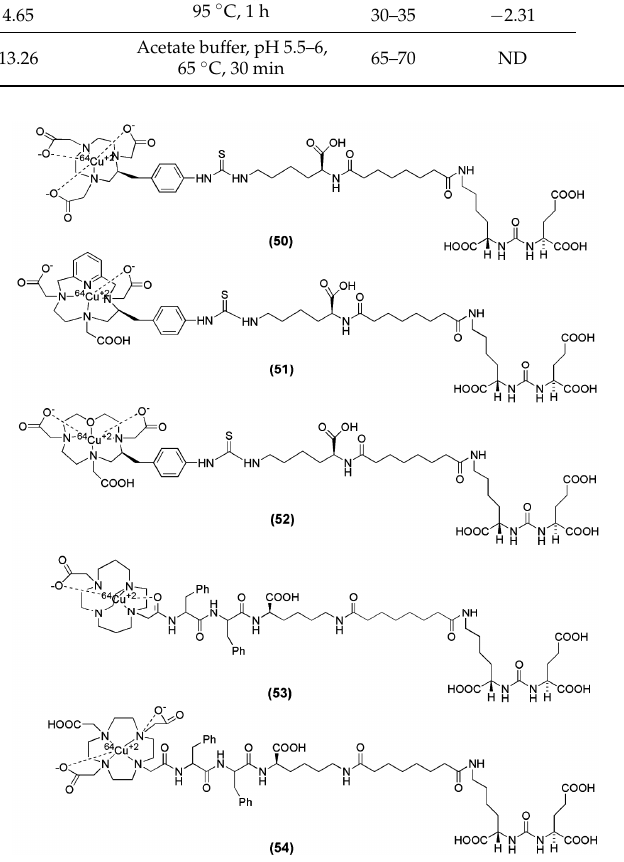
Figure 17. Chemical structures of the PSMA-based inhibitors ( 50 – 54 ) labeled with 64 Cu [139].